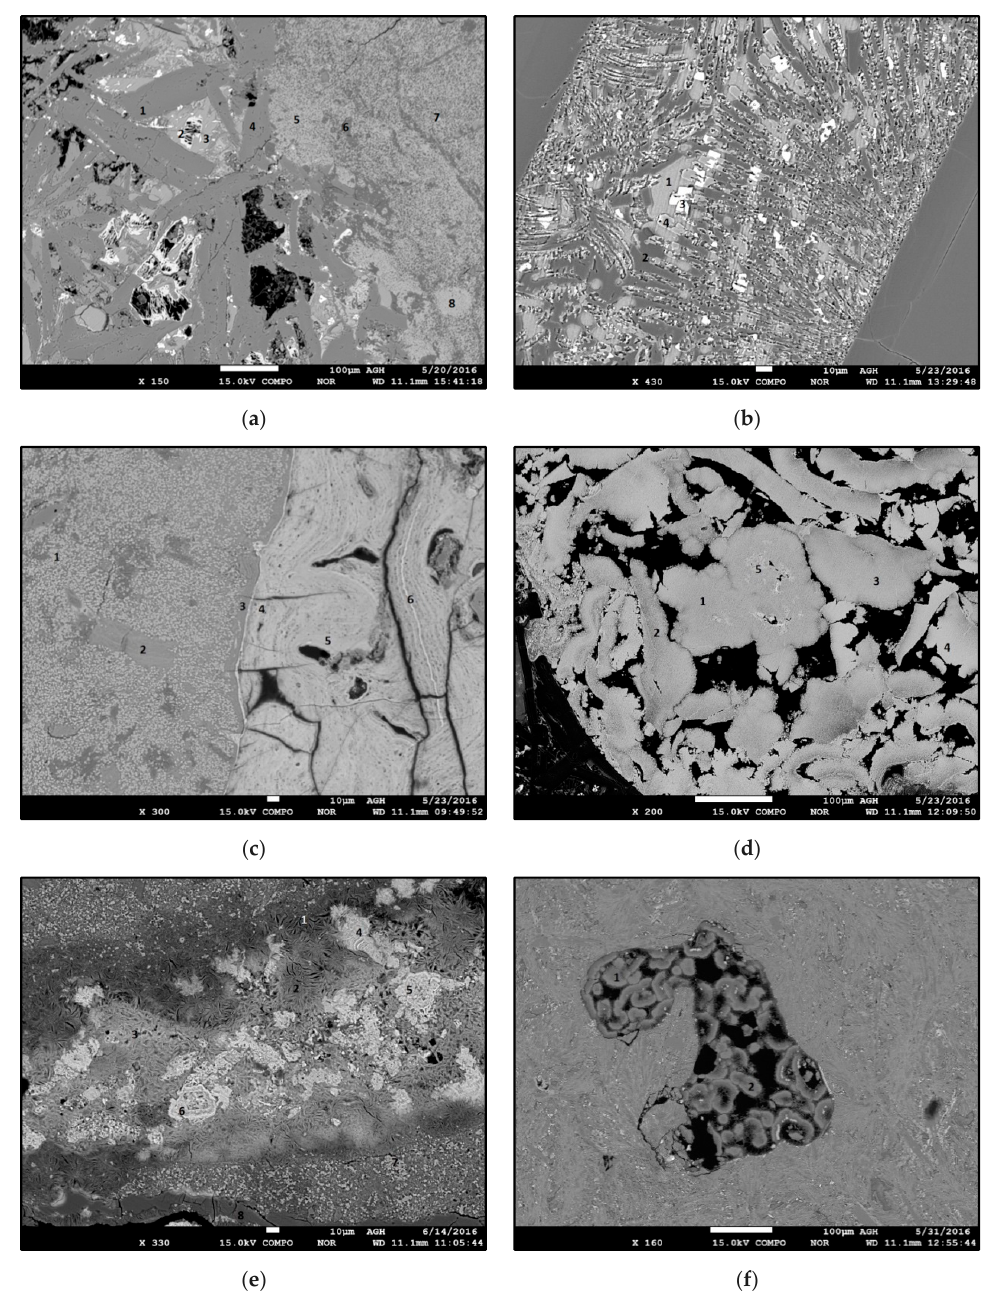
Figure 6. Representative EPMA images of DHR basalts and substrate-crust border zone: ( a ) several plagioclase twinnings (1, 4), hydroxyapatite (3, 5, 7, 8), remnants of pyroxenes (6) and pseudobrookite; ( b ) part of pertitized, zonated plagioclase phenocryst (1, 2) with remnants of automorph pyroxene (4) (ferrosilite) and pseudobrookite (3); ( c ) transition zone with graspy basalt texture and pyroxene remnants (2); amorphic hydroxyapatite with small admixture of Zn, Fe, REE and depleted with F − (1); phyllosilicate substrate coating developed as a weathering product (3) (celadonite-ferroceladonite or Fe-saponite?); colomorphs with laminae of asbolane (6) and vernadite (4, 5) with >1.7% Ti + Co and ~1.0 % Ni + Cu + Zn; ( d ) worm-like phyllosilicate filings from basalts vesicle (nontronite and celadonite); ( e ) weathered basalts vesicule filled-up with the flower-like radial porous clusters of Fe-chlorites, celadonite and nontronite (showing higher contents Cr and Y); small intergrowth (~40 µ m) of Ni-asbolane (4) and Ni-Cu asbolane (~40 to 50 µ m) (5, 6); (7) hydroxyapatite depleted with F (0.5%) and REE (Y + La) (0.5%); (8) small vein (10 to 20 µ m) composed of zeolite (Na-K philipsite); ( f ) basalt vesicule filled-up with worm-like phyllosilicate mixture (ferroaluminoceladonite and